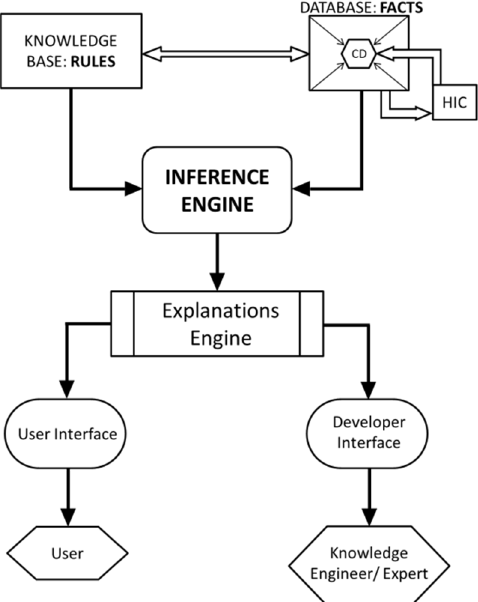
Figure 4. Production-rules expert system with the knowledge information compression module. Note. HIC = human information compression; CD = compressed data, reduced by the conceptual engine.